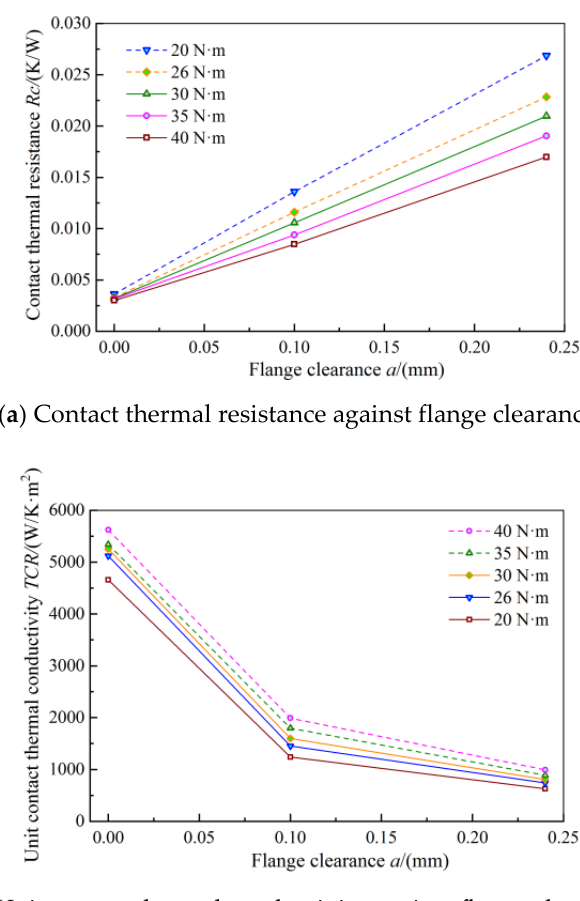
Figure 14. Effect of flange clearances with contact thermal resistance and thermal conductivity at different tightening torques for the 304 stainless steel – Q345R material.